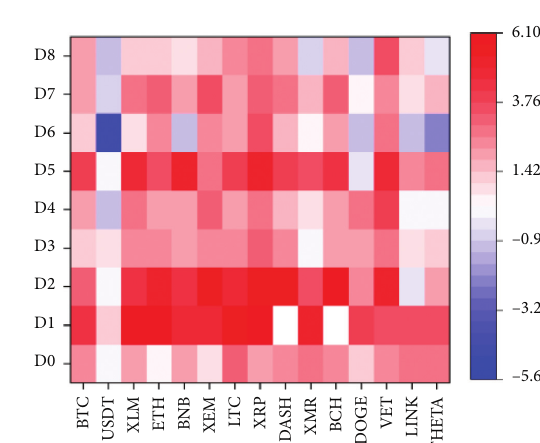
Figure 15: XEM to the other.